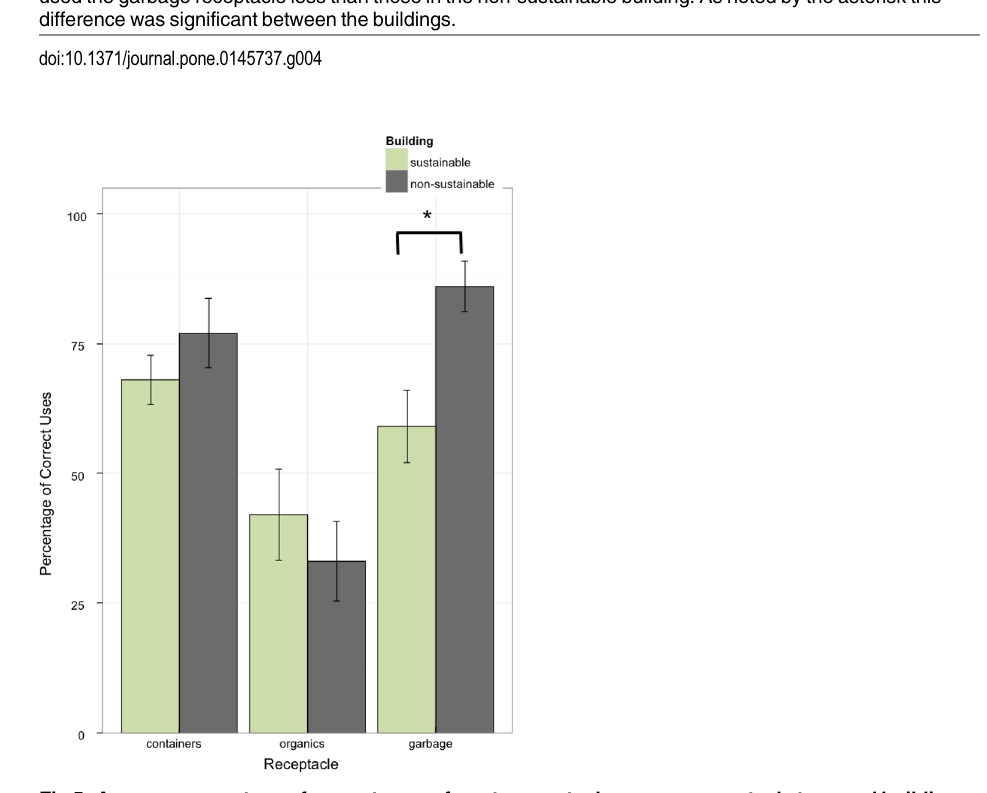
Fig 5. Average percentage of correct uses of waste receptacles across receptacle type and building type. A greater percentage of items were accurately placed in the garbage receptacle in the non-sustainable